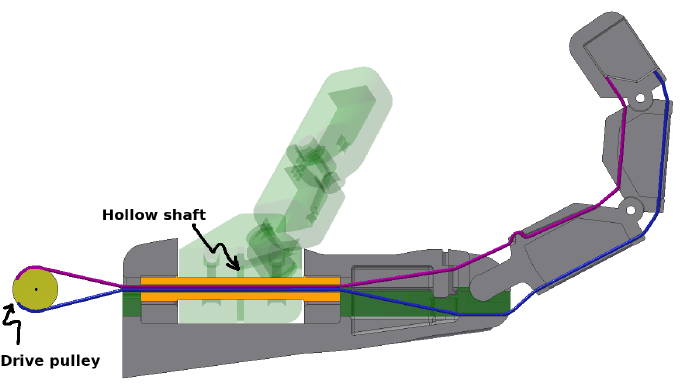
Figure 4. Lateral cross-sectional view of the index finger. The top tendon generates the flexion, and the bottom tendon, the extension movement. The connection to the pulley allows to pull only one of them while releasing the other.